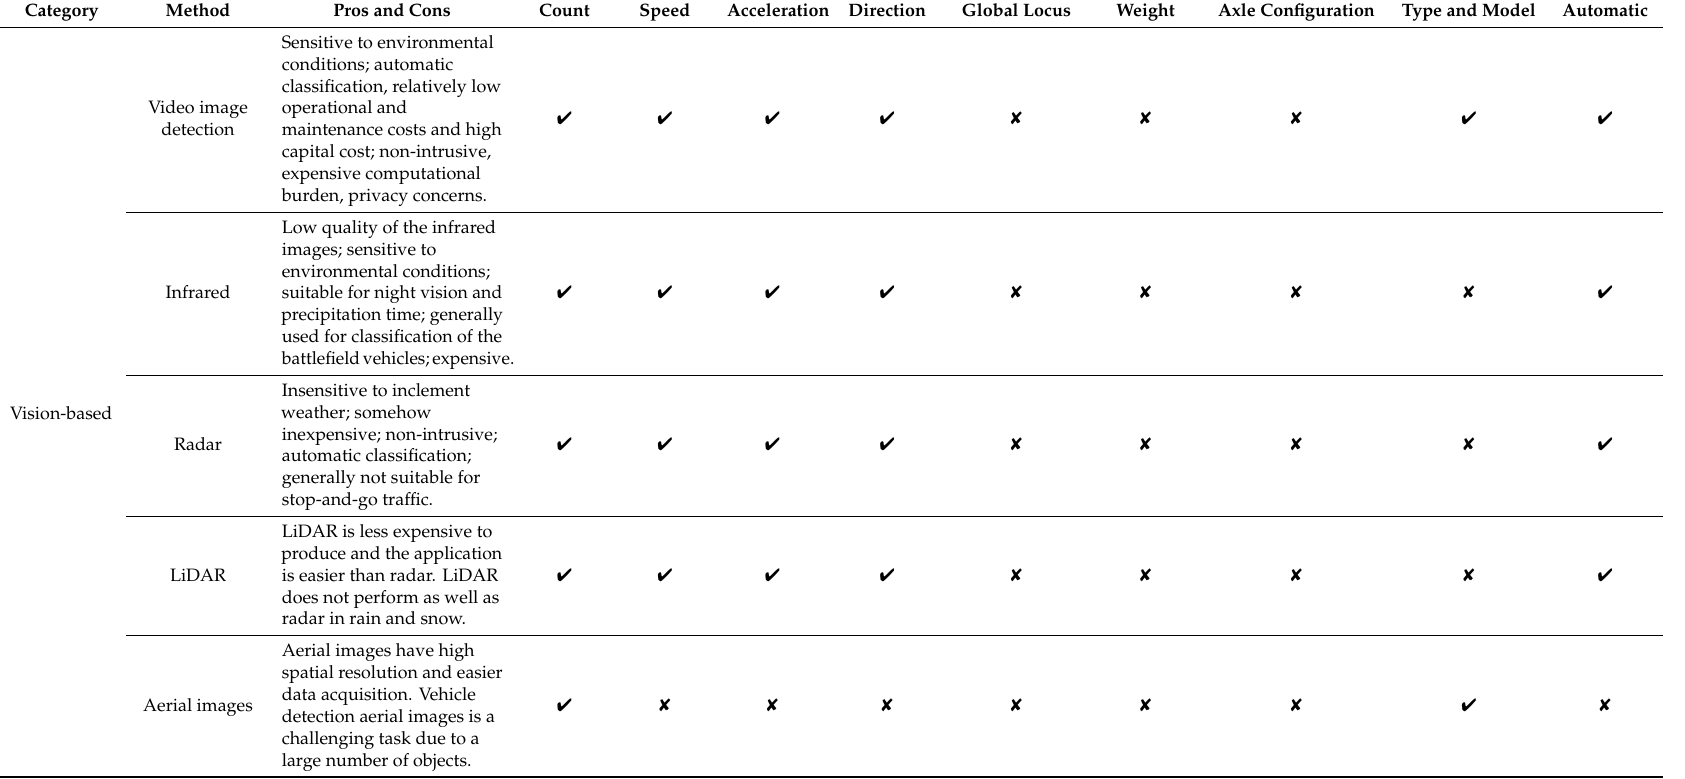
Table 5. Pros and cons of VC